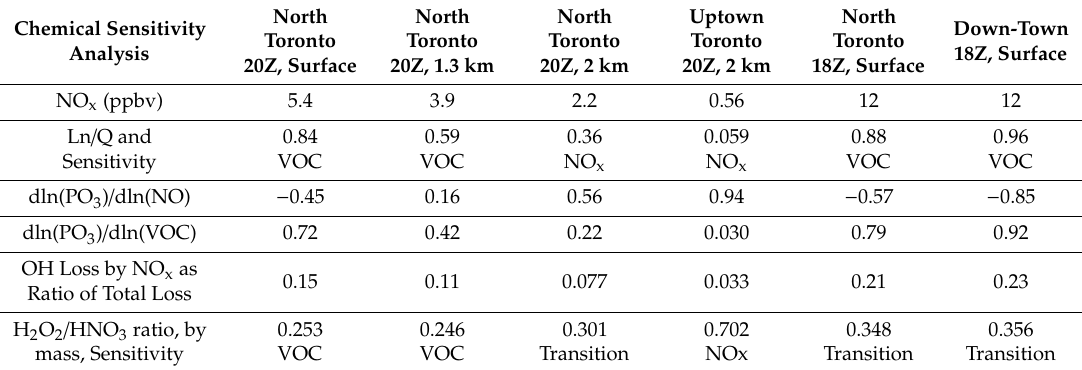
Table 3. Chemical coordinate analysis results for ozone production sensitivity to precursor concentration changes for di ff erent locations in lake-breeze circulation on 28 July